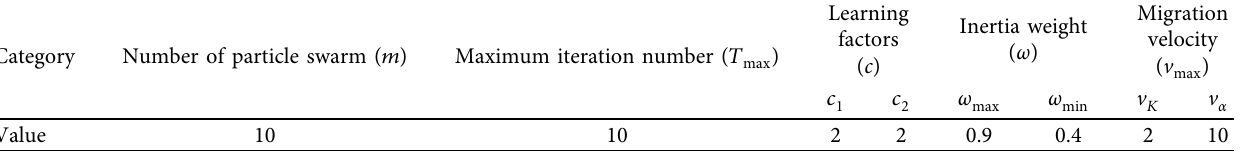
Table 1: Setting the PSO